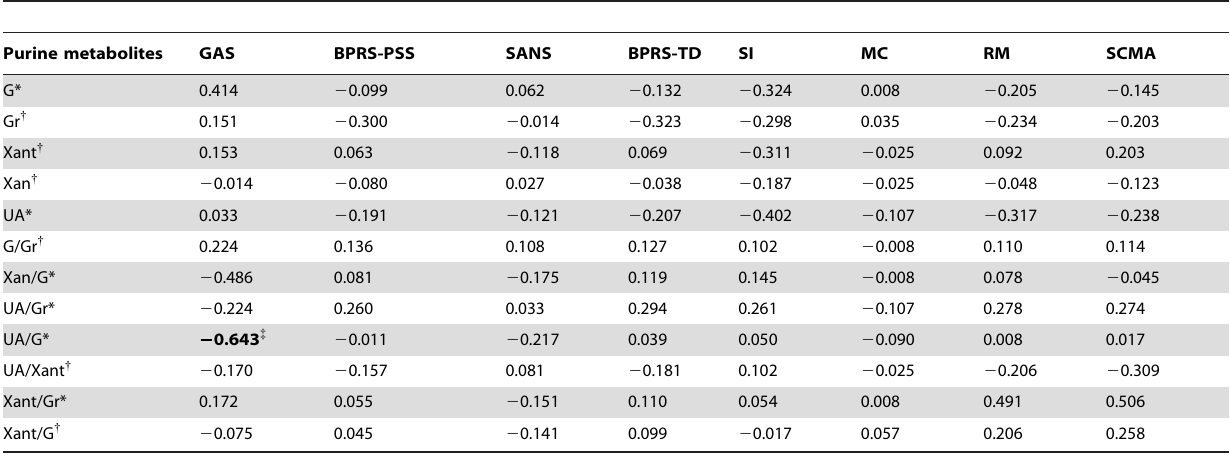
Table 3. Correlation coefficients between purine metabolites and clinical assessments from first-episode neuroleptic-naive patients with schizophrenia at baseline before antipsychotic treatment.